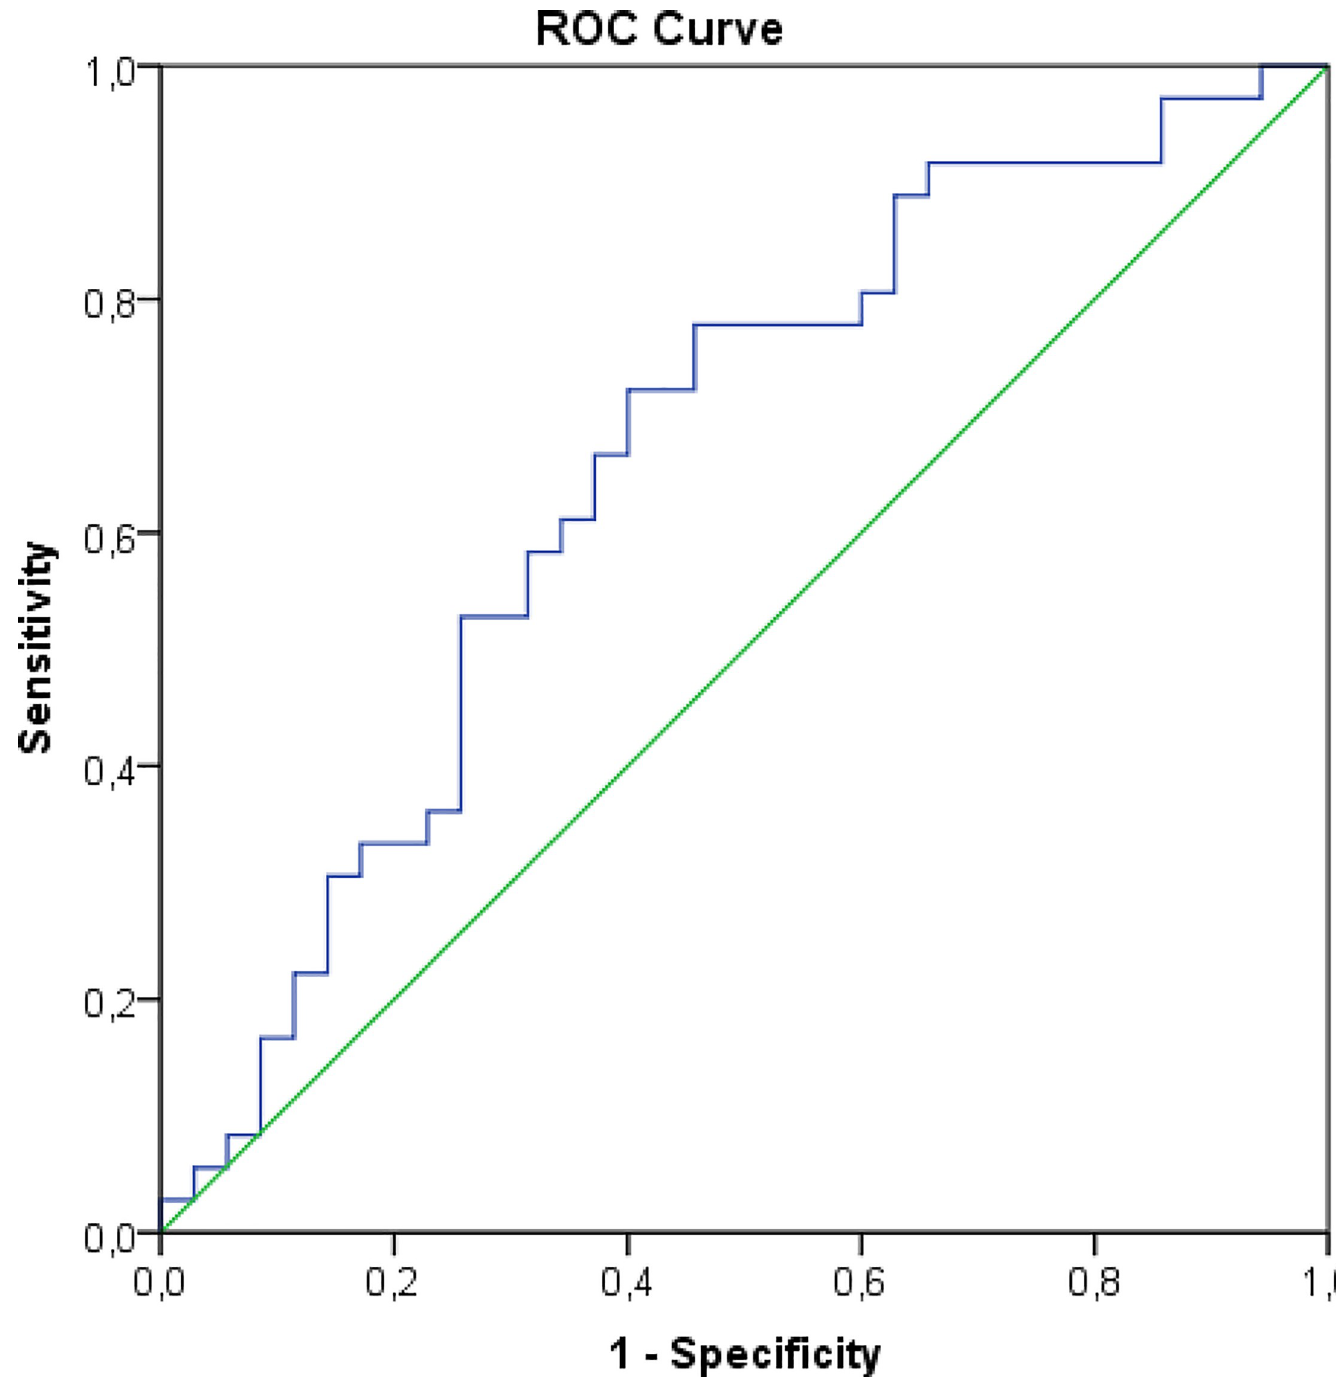
Fig 2. ROC curve between adjusted kidney volume and an estimate glomerular filtration rate (eGFR) at 1 year in living donors transplantation (curve area = 0.662, p = 0.019).